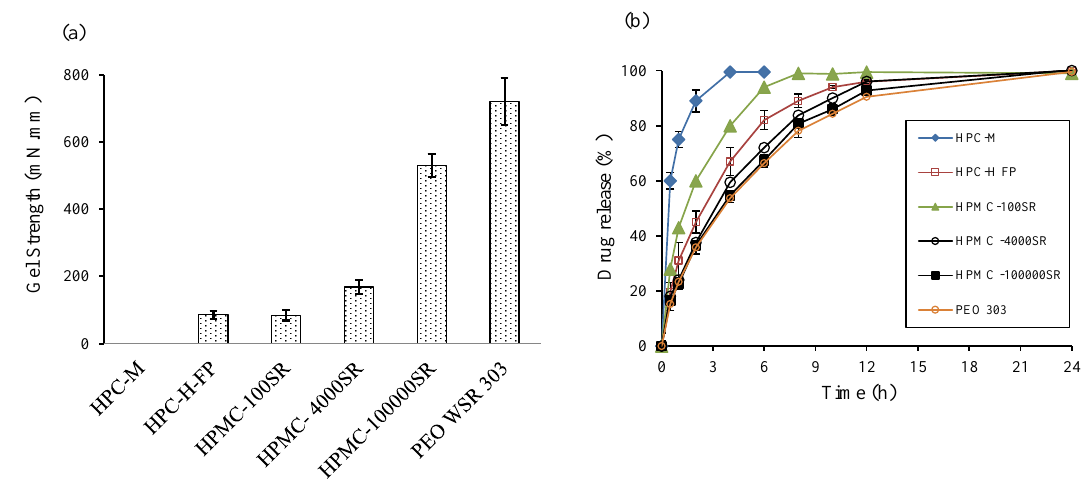
Figure 1. ( a ) Gel strength (mN · mm) of various hydrophilic using the Texture analyzer after being swollen in water at 37 ◦ C. ( b ) Comparison of drug release profiles of the effervescent floating tablets (EFTs) with different hydrophilic